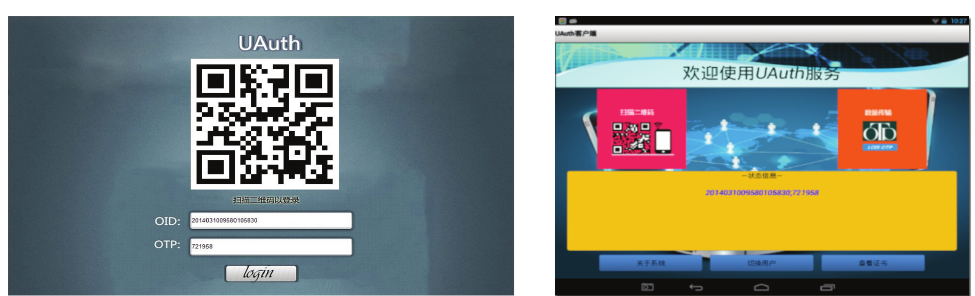
Figure 5. Our Implementation of the UAuth login page and terminal